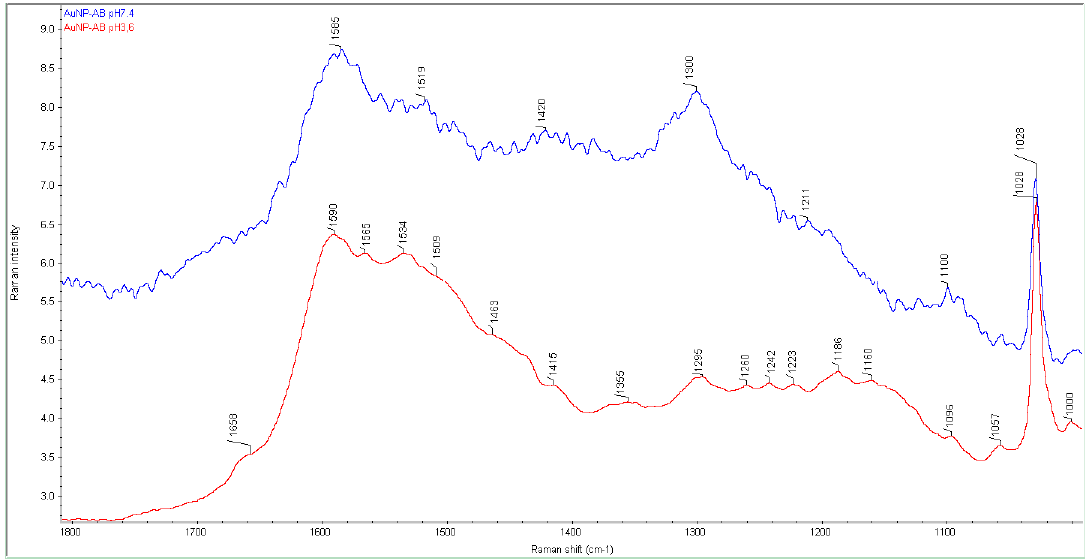
Figure 10. A comparison of the Raman spectra of the nanoparticles obtained in pH 3.6 and 7.4. Table 4. A collection of the wavenumbers from the theoretical and experimental Raman spectra of AB and the nanoparticles.